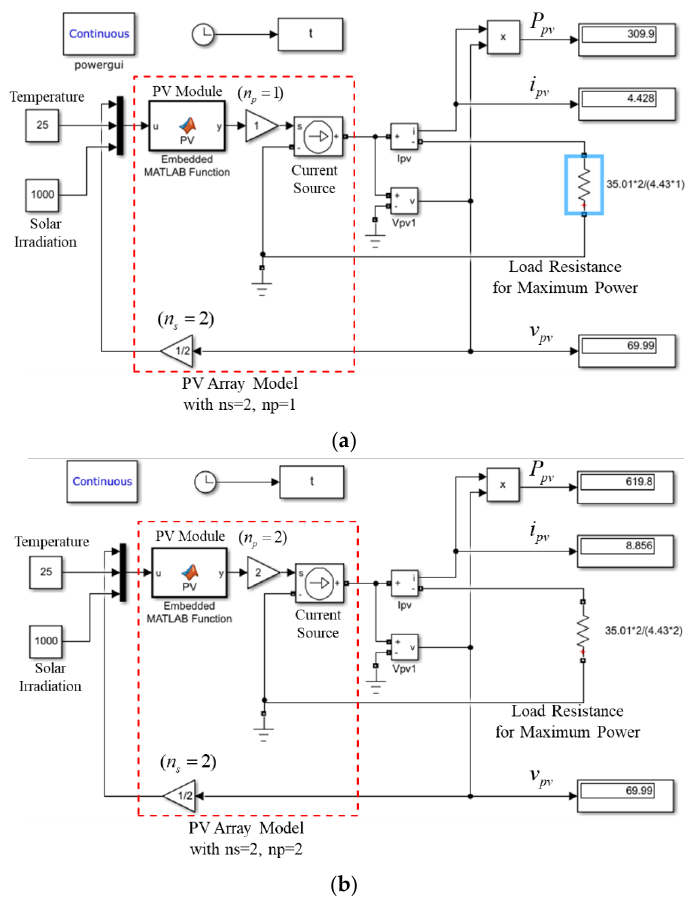
s = 2, n p = 1, ( b ) with n s = 2,